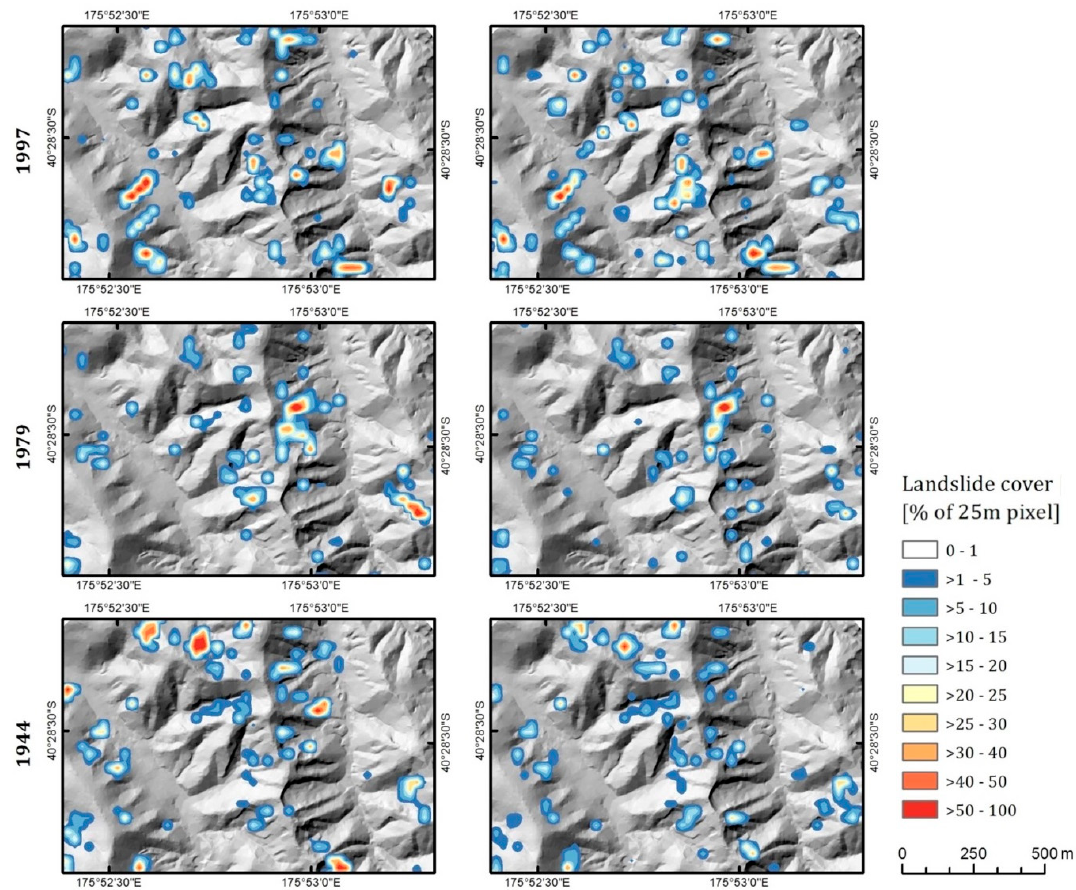
Figure 8. Comparison of landslide hotspot maps based on the manual landslide mapping results ( left ) and on the OBIA results ( right ) for the years 2011, 1997, 1979, and 1944 displayed on a shaded relief for a subset from the northwestern part of the study area.